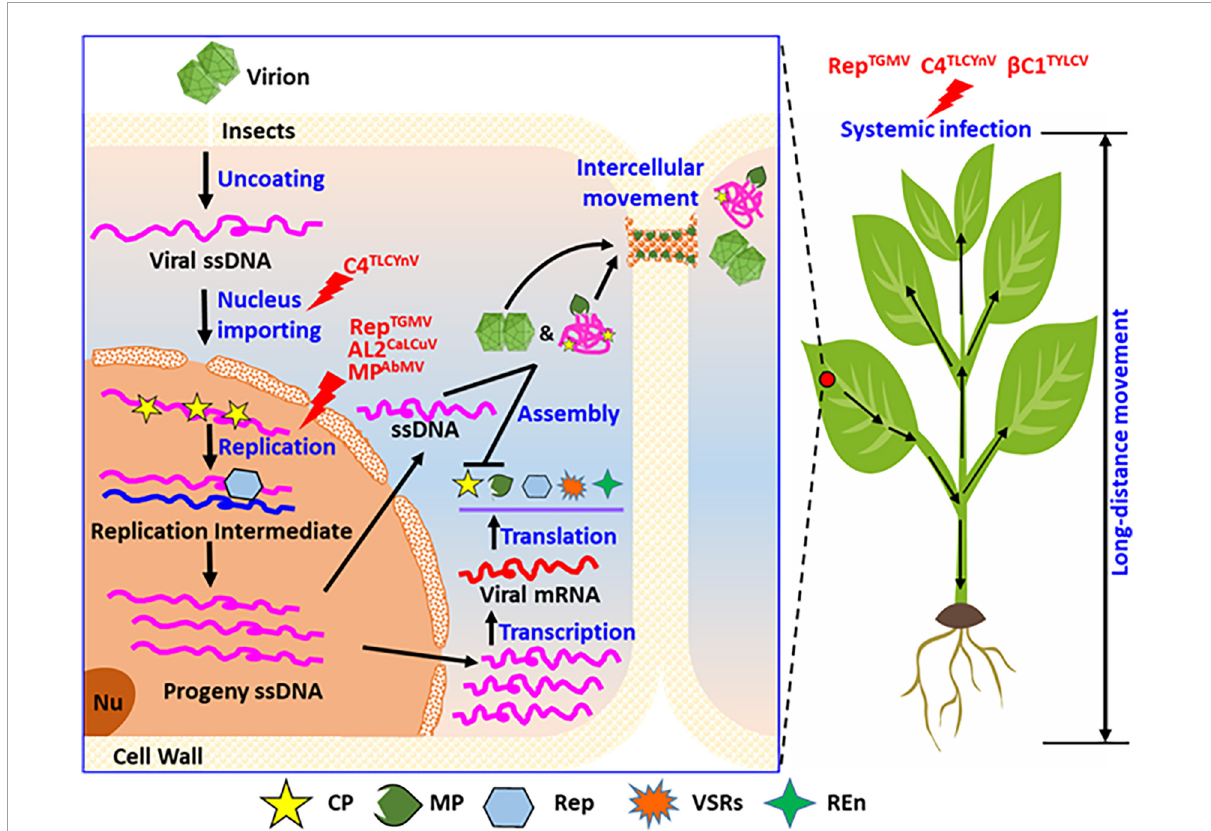
FIGURE4 Summary of the phosphorylation functions of proteins encoded by geminiviruses during their life cycle. Considering the entire cell and whole plants, phosphorylation modification of the viral proteins regulates the different infection steps in the life cycle of geminiviruses in host plants, including the nuclear import, genomic DNA replication, and systemic infection. As shown, phosphorylation modification of C4 (C4 TLCYnV ) affected virus nucleocytoplasmic shuttling. Phosphorylation modification also affects the virus replication, for instance, replicase of TGMV (Rep TGMV ), AL2 of CaLCuV (AL2 CaLCuV ), and MP of AbMV (MP AbmV ). Phosphorylation modification also affects virus systemic infection of host plant, such as replicase of TGMV (Rep TGMV ), C4 of TLCYnV (C4 TLCYnV ), and β C1 of TYLCV ( β C1 TYLCV ). REn, replication enhancer; PD, plasmodesmata; Nu,